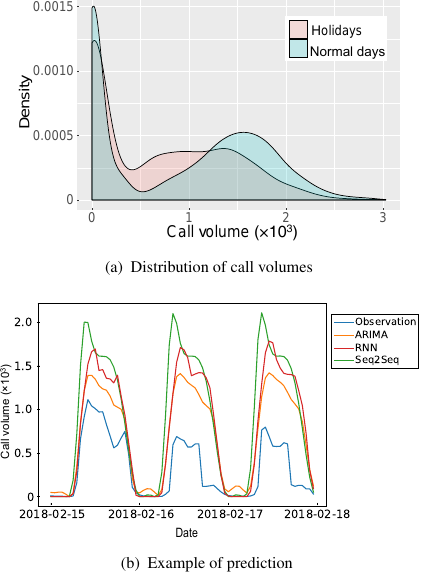
Fig. 1 An example of call arrival prediction.